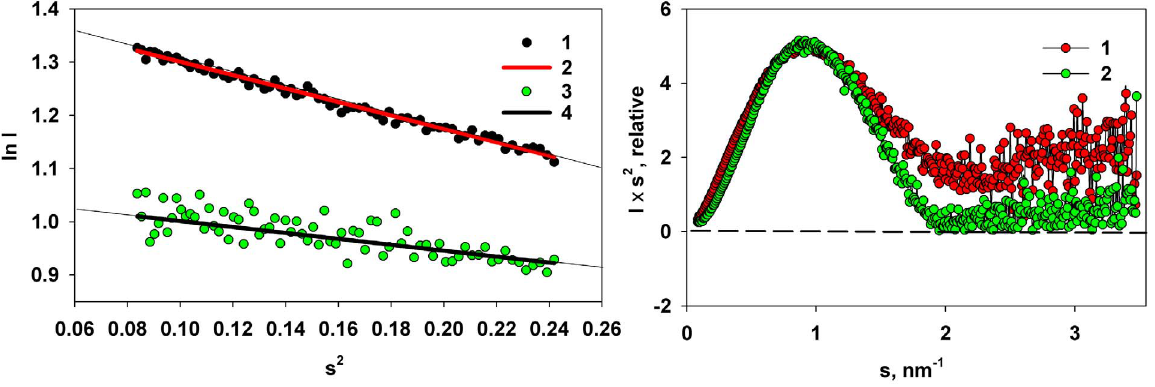
Figure 4. Guinier and Kratky plots for the M1 protein and for the NM-domain. Left panel: Guinier plots of M1 (1 – experimental data; 2 – Guinier fit) and of the NM-domain: (3 – experimental data; 4 – Guinier fit). Right panel: Kratky plots for M1 (1) and NM-domain (2).